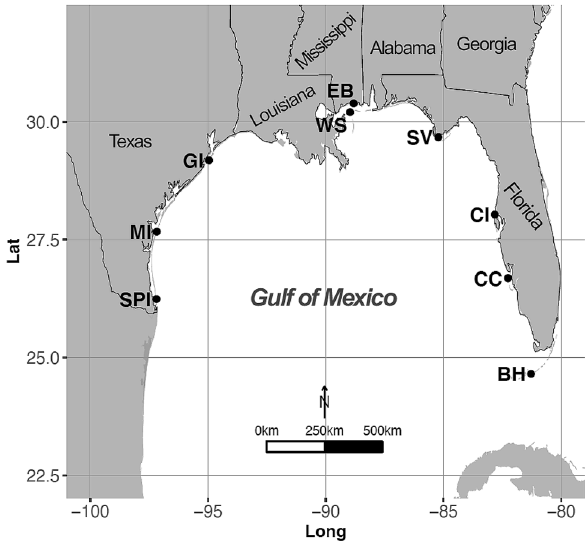
Figure 1. Sand beach collection sites along the U.S. Gulf of Mexico coastline used to study fungal